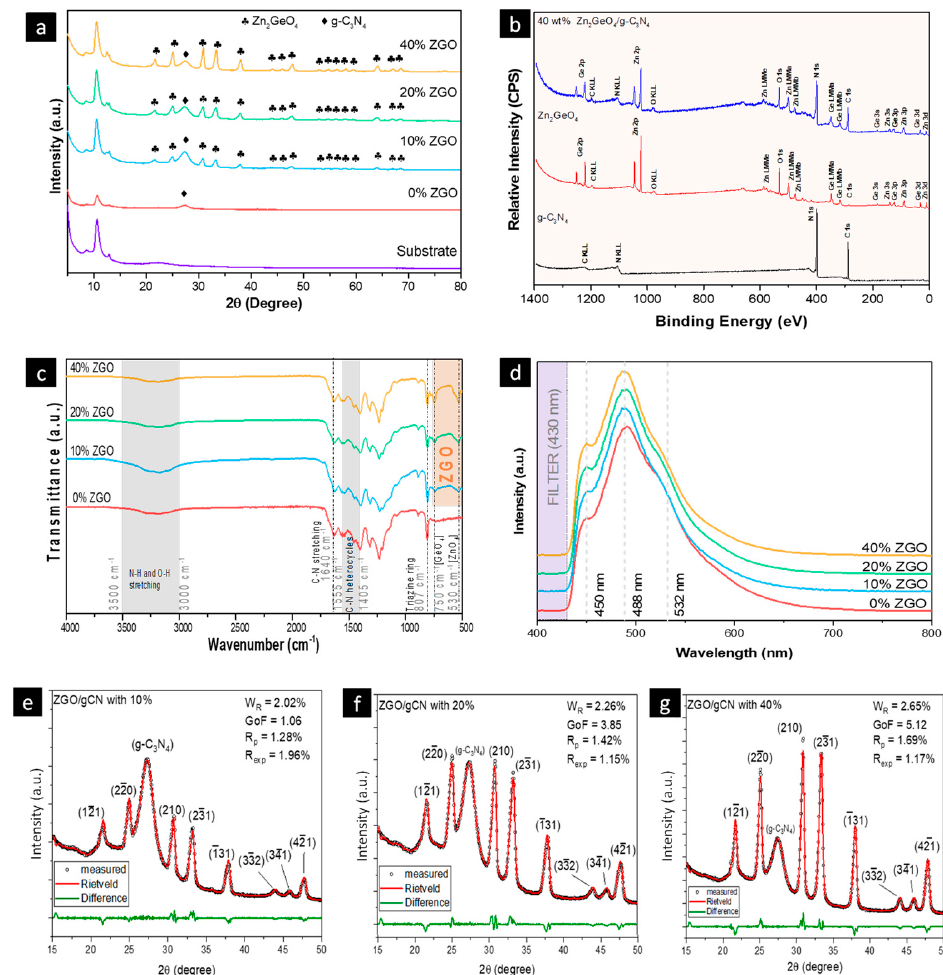
Figure 1. Structural, vibrational, and optical characterization of Zn 2 GeO 4 /g-C 3 N 4 nanocomposites. ( a ) PXRD patterns, ( b ) XPS survey spectral, ( c ) FTIR spectral, and ( d ) PL spectral at room temperature of Zn 2 GeO 4 /g-C 3 N 4 nanocomposites. ( e – g ) Fitting parameters of the Rietveld refinement data (W R , GoF, R p and R exp ) of samples prepared with 10, 20, and 40 wt% of Zn 2 GeO 4 , respectively.